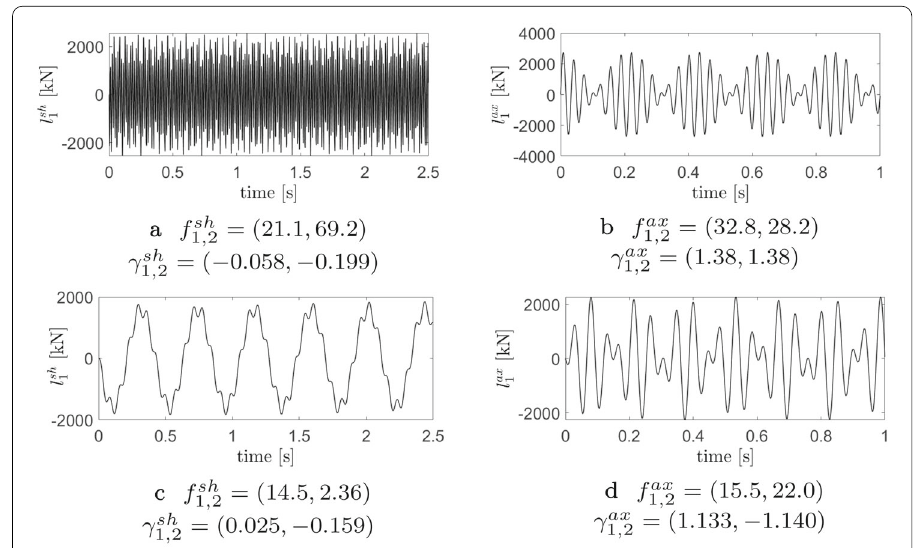
Fig. 6 Examples of time evolutions of the loads (case 1) applied to the first floor of the building in the x (left column) and z (right column) directions. For the sake of visualisation, the sketched time interval for the loads applied in the x direction has been restricted to I = [0 , 2 . 5]